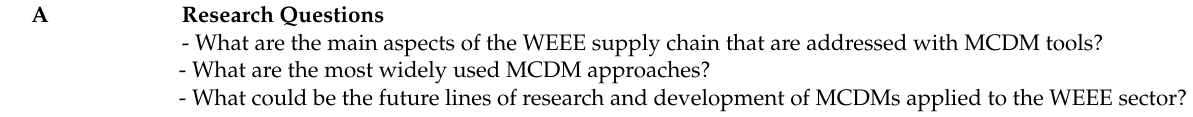
Table 1. Search phase